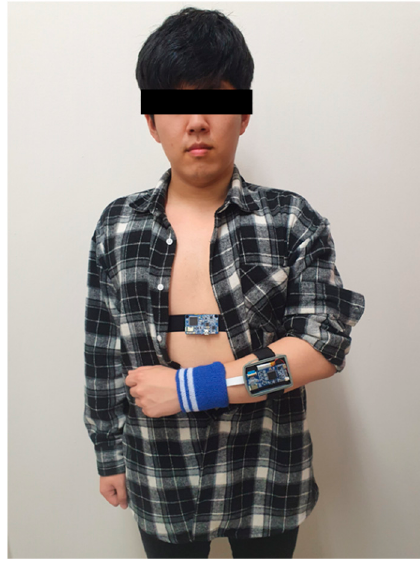
Figure 3. The picture of the subject being equipped with an ECG and multi ‐ channel PPG measurement system.